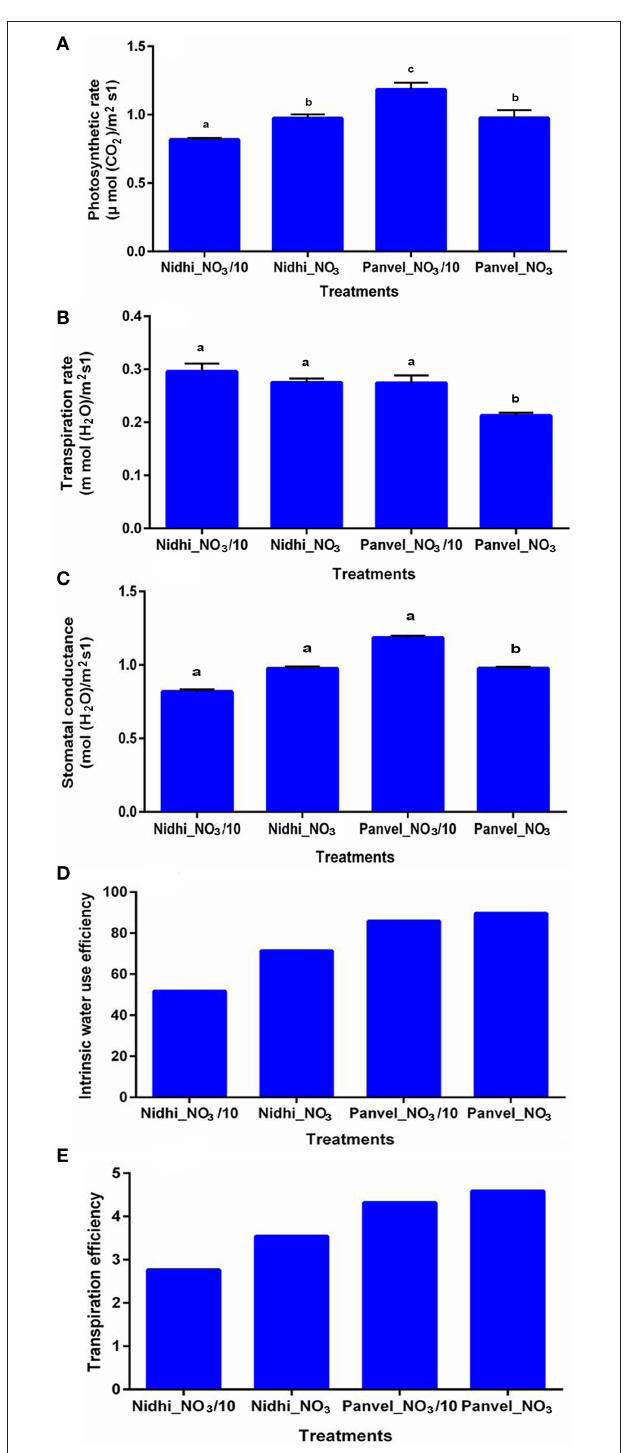
FIGURE 9 | Validation of biological processes: validation was done by using Licor 6400XT (LI-COR, Lincoln, NE, USA) on 21-day-old grown plants. Plants were grown in garden soil and fertilized with Arnon–Hoagland medium having nitrate as the sole source of N with 15mM N concentration as control while 1.5mM was used as a test. Measurement was done in five biological